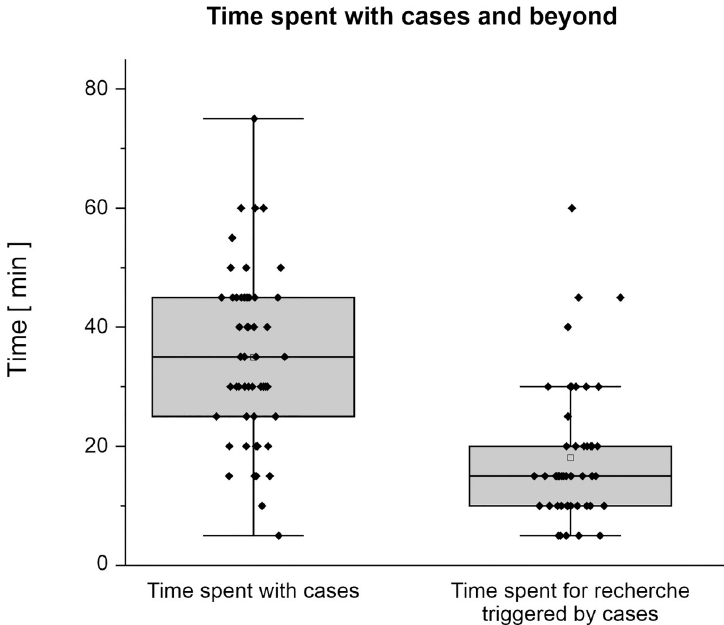
Fig 1. Approximate time spent with cases and for additional research triggered by the cases ( n = 46–51). Data is presented as box plots with dots representing original